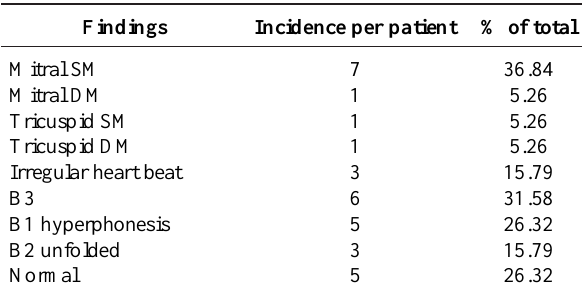
Table 3. Cardiac auscultation in patients with cardiac tumours